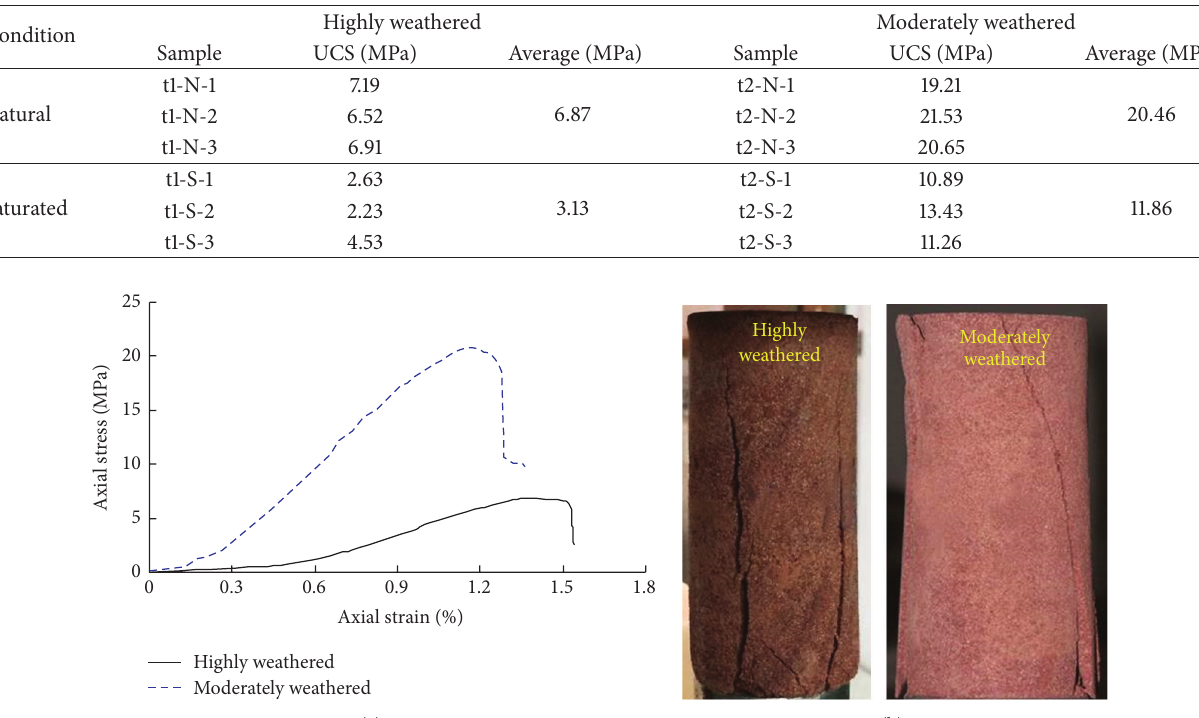
Figure 6: The results of the uniaxial compressive tests: (a) stress-strain curves and (b) the failure types of the Zigong argillaceous siltstone with different degree of